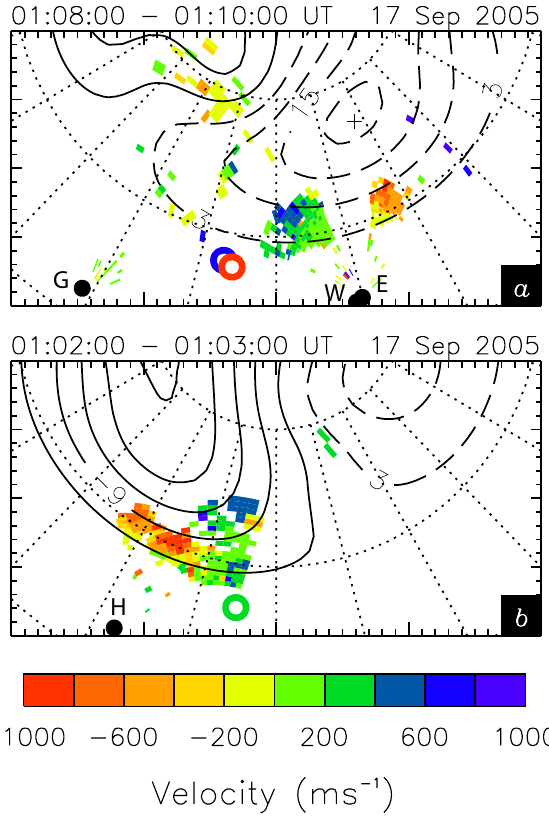
Fig. 4. (a) SuperDARN line-of-sight velocity data from the Ice- land East, Iceland West, and Goose Bay radars at 01:08 UT on 17 September 2005 in the same format as in Fig. 2a. (b) As (a) but for the Halley and Sanae radars in the Southern Hemisphere at 01:02 UT.